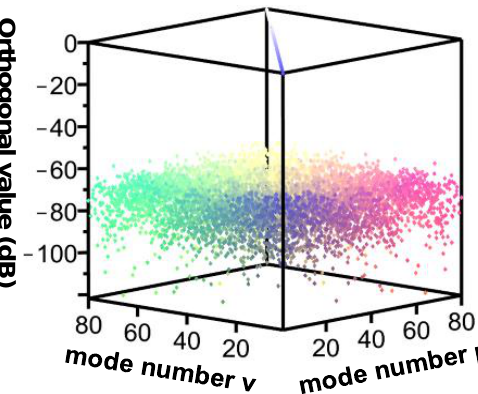
Figure 9. Relationships between the orthogonal values of 80 guided modes for the proposed FBG-OADM.